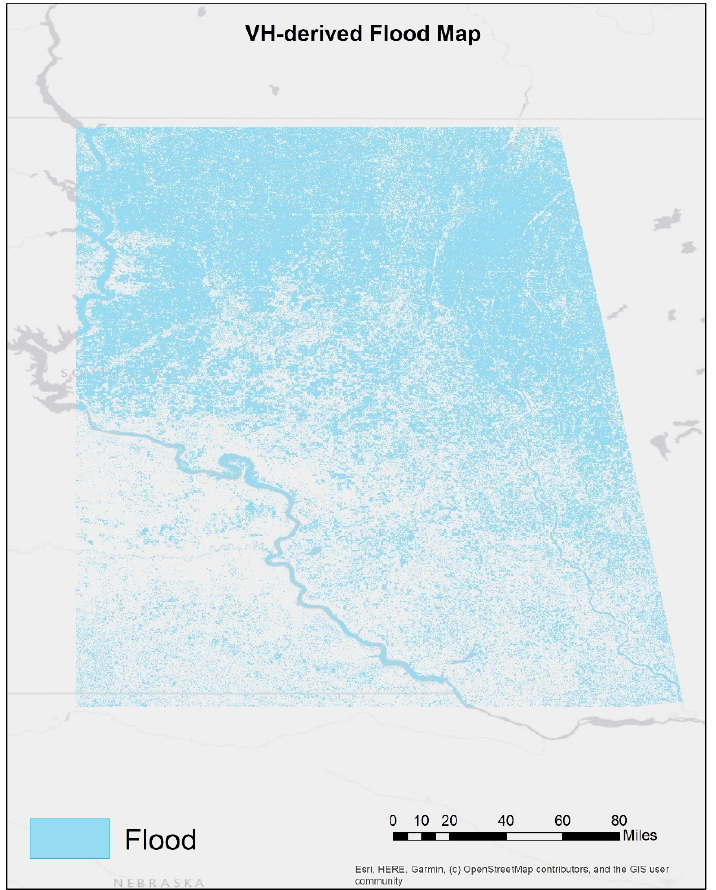
Figure 11. Flood map at 30 m scale derived using pixels greater than the optimum threshold value.